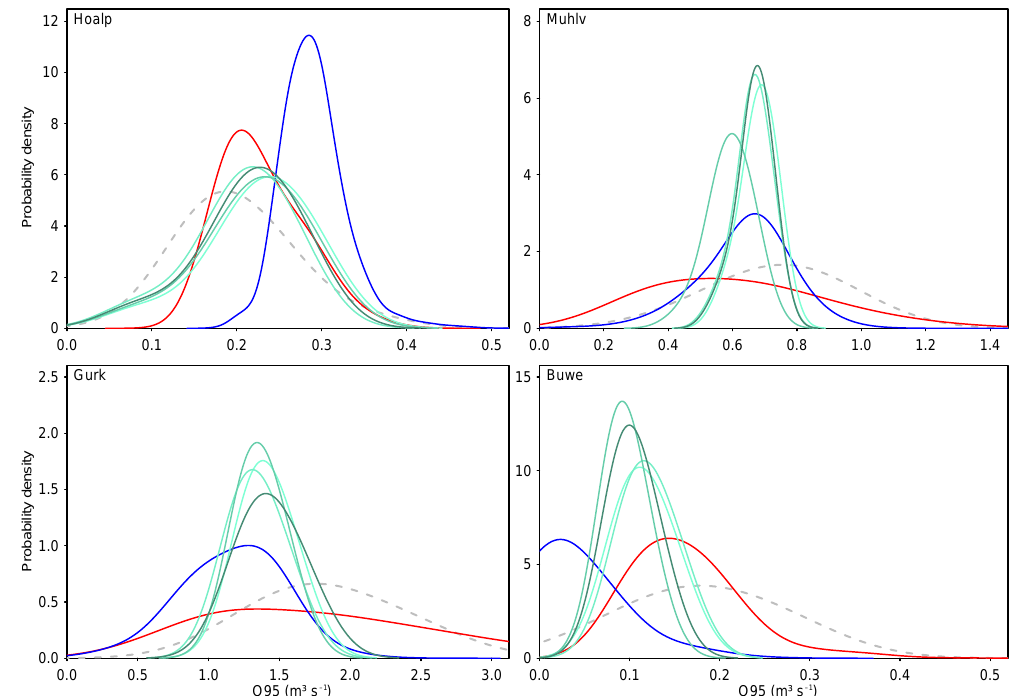
Figure 11. Probability density functions (pdf’s) of annual Q 95 low flows 2021–2050 of the three-pillar projections for the Hoalp, Muhlv, Gurk and Buwe catchments as in Fig. 10. Pillar 1: extrapolation of observed low flows (blue). Pillar 2: climate projections and runoff modelling (different shades of green). Pillar 3: extrapolation of stochastic rainfall characteristics and runoff modelling (red). The pdf’s represent both variability within the period and uncertainty (pillars 1 and 2) and variability alone (pillar 3). For comparison, observed Q 95 in the reference period (1976–2008) is shown (dashed grey